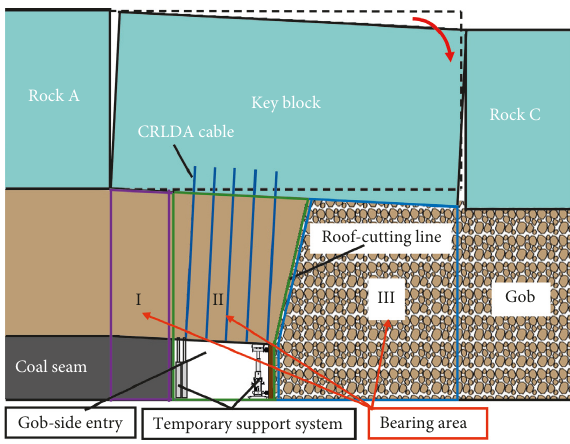
Figure 4: Bearing areas under the key